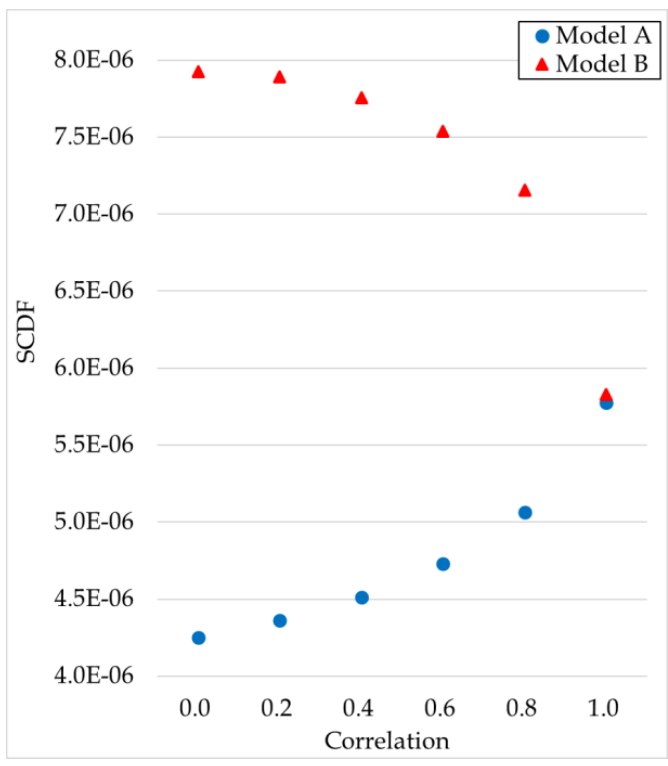
Figure 16. Plots of SCDF versus seismic correlation.